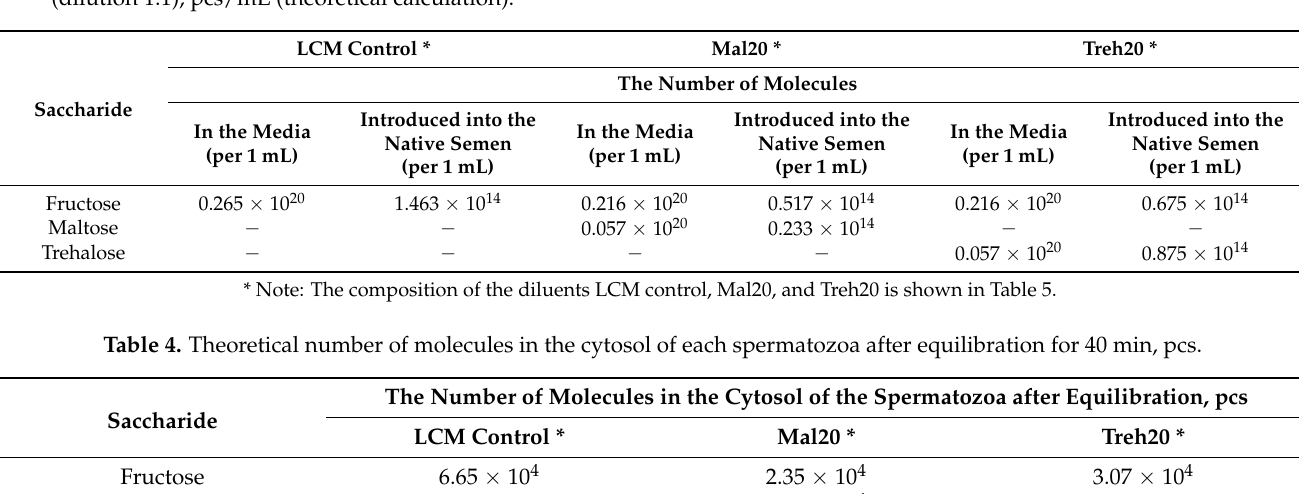
Table 3. Number of molecules in the media and the number of molecules introduced into the native semen after equilibration (dilution 1:1), pcs/mL (theoretical calculation).